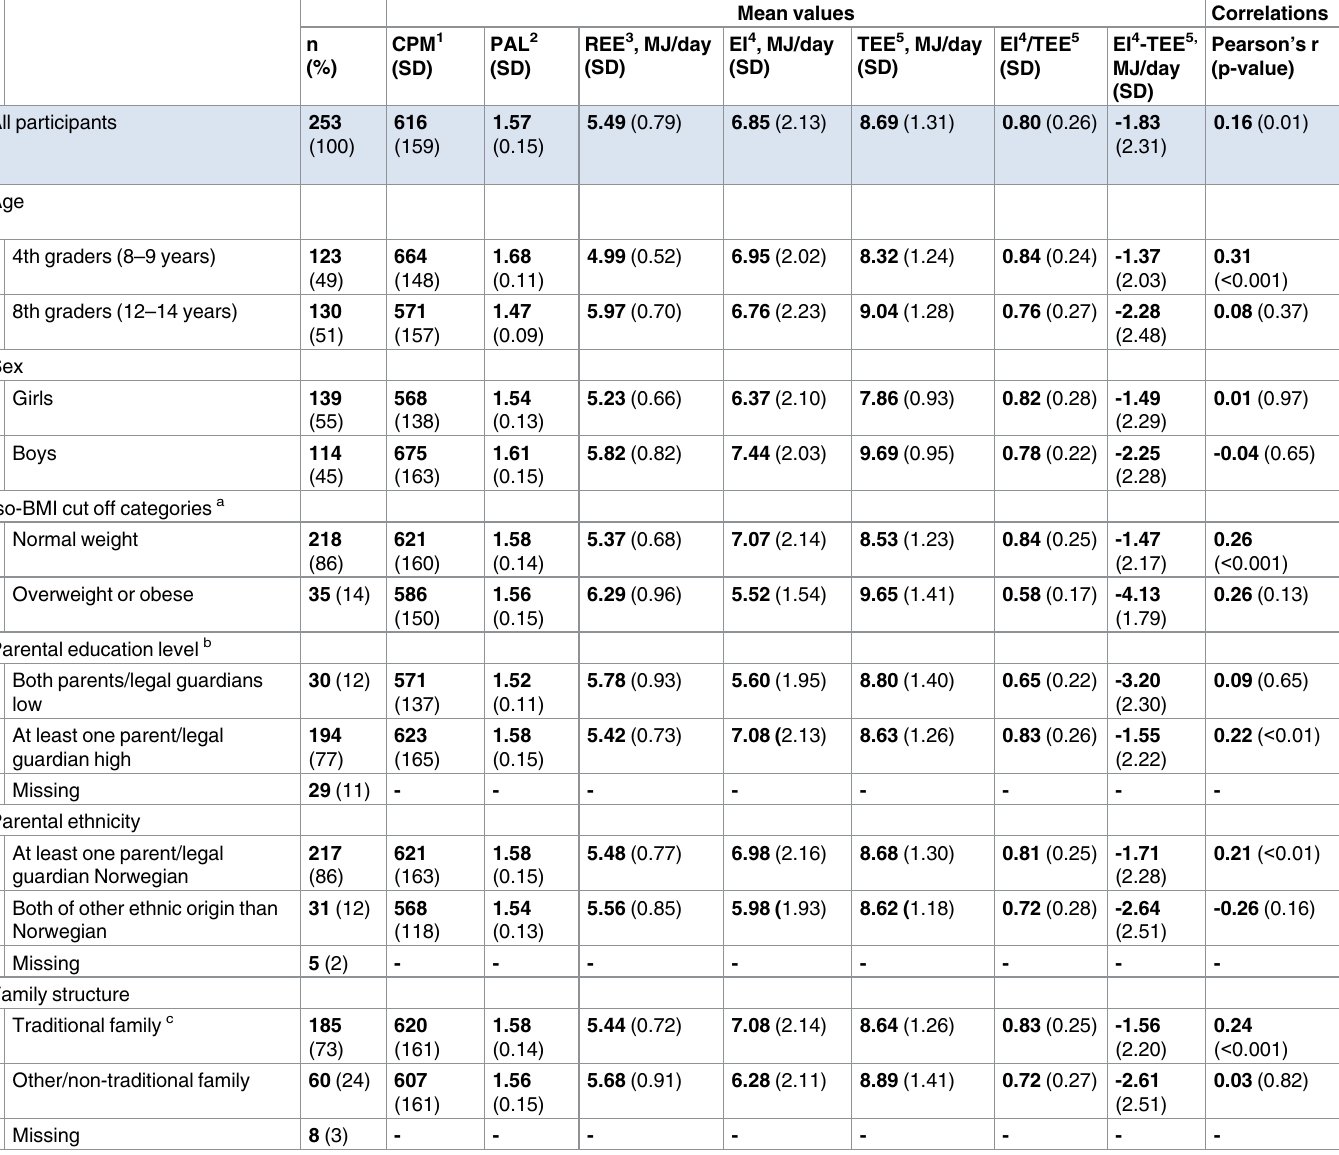
Table 1. Characteristics of study sample, measuresof physical activity, reported energy intake, resting- and total energy expenditure, energy bal- ance, and Pearson’s correlation between energy intake and total energy